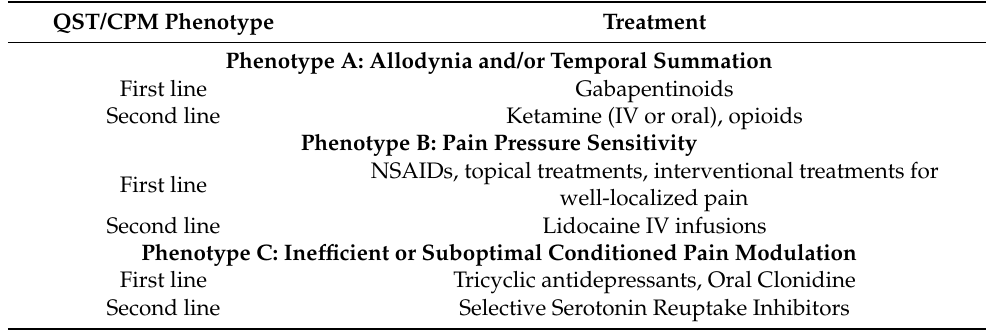
Table 1. Treatment recommendations according to QST/CPM